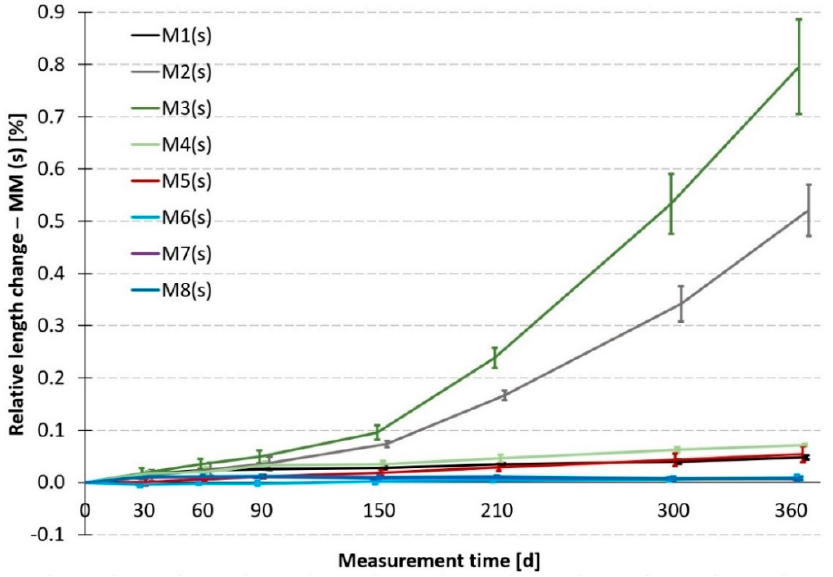
Figure 11. Dependence of relative length changes on the immersion time of the samples in the sulfate bath.